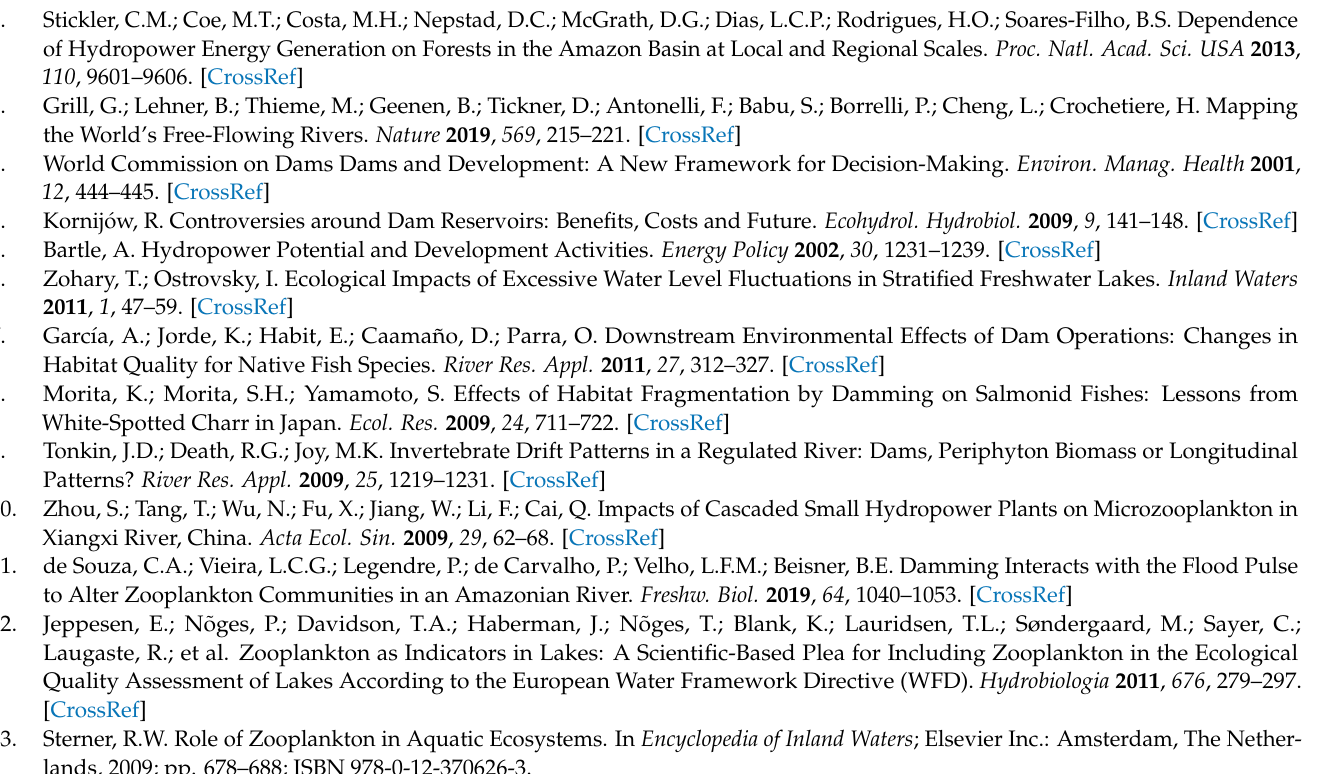
contribution; Table S1: Results of SIMPER concerning the similarity of groups; Table S2: Results of SIMPER concerning the dissimilarity of